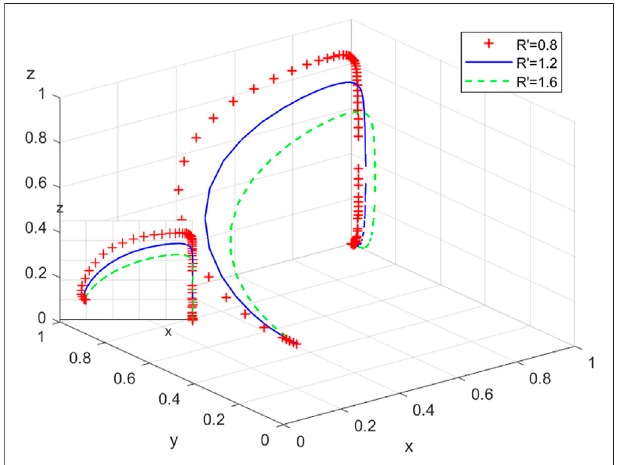
FIGURE6 | Impact of the losses ofthe MEs due to new media exposure on the evolution track of the tripartite evolutionary game.